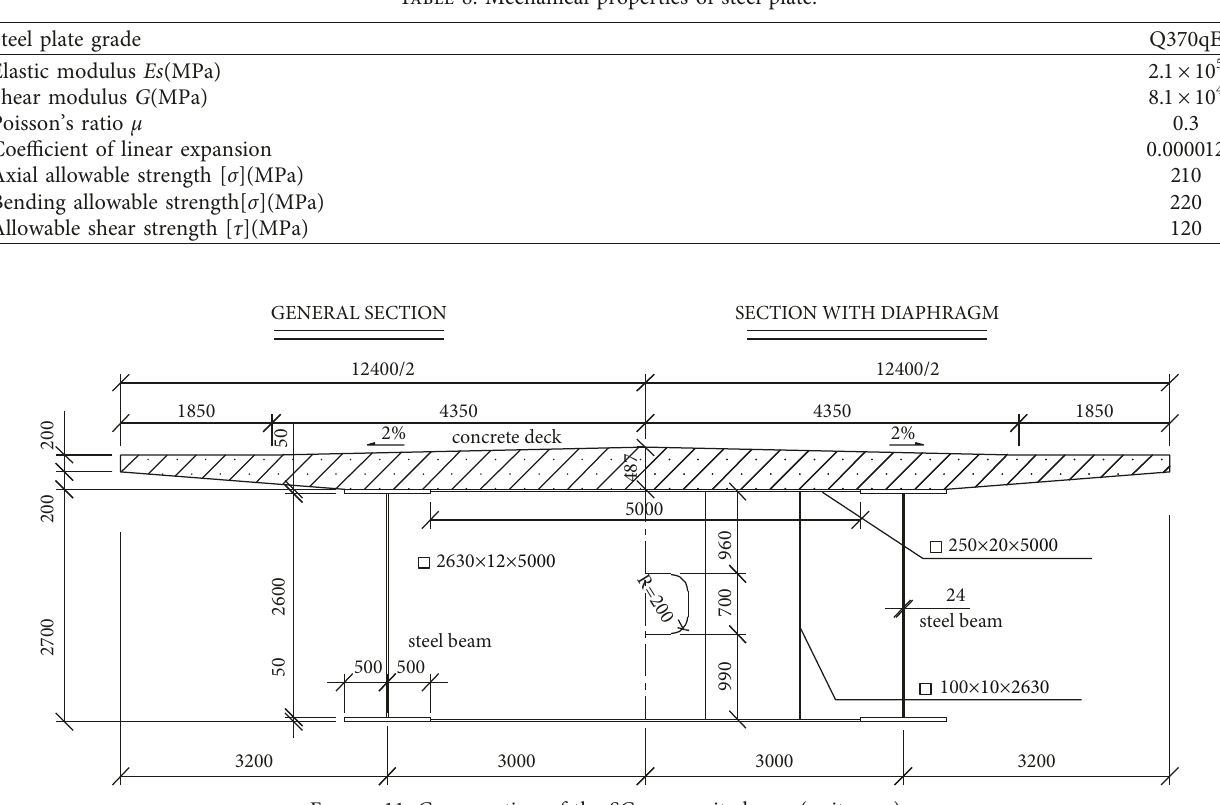
Figure 11: Cross-section of the SC composite beam (unit: